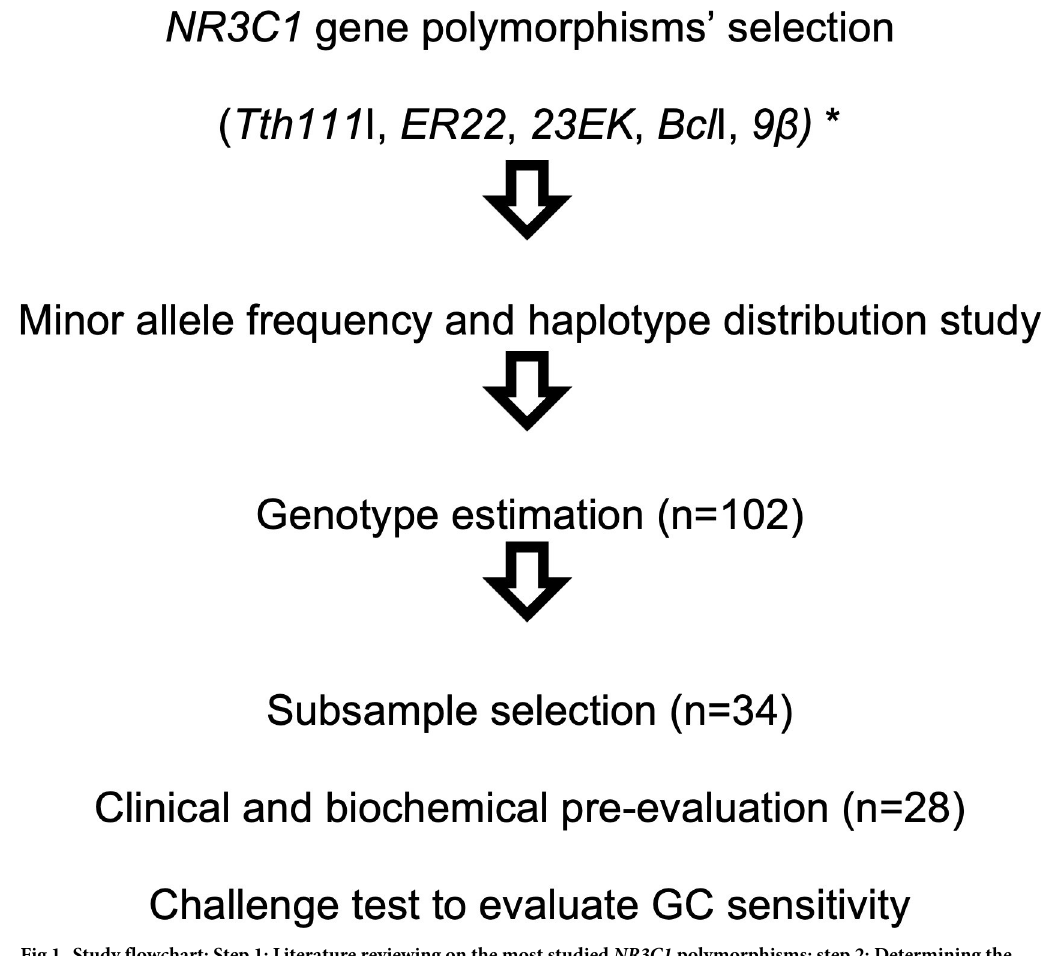
Fig 1. Study flowchart: Step 1: Literature reviewing on the most studied NR3C1 polymorphisms; step 2: Determining the frequencies of minor alleles and haplotypes; step 3: Estimation of genotypes; step 4: Selection of genotypes with greater sensitivity or greater resistance to GC, for genotype-phenotype association study among subjects with CAH. � (SNPs ID: rs10052957, rs6189, rs6190, rs41423247, rs6198). CAH: congenital adrenal hyperplasia; GC: glucocorticoid.